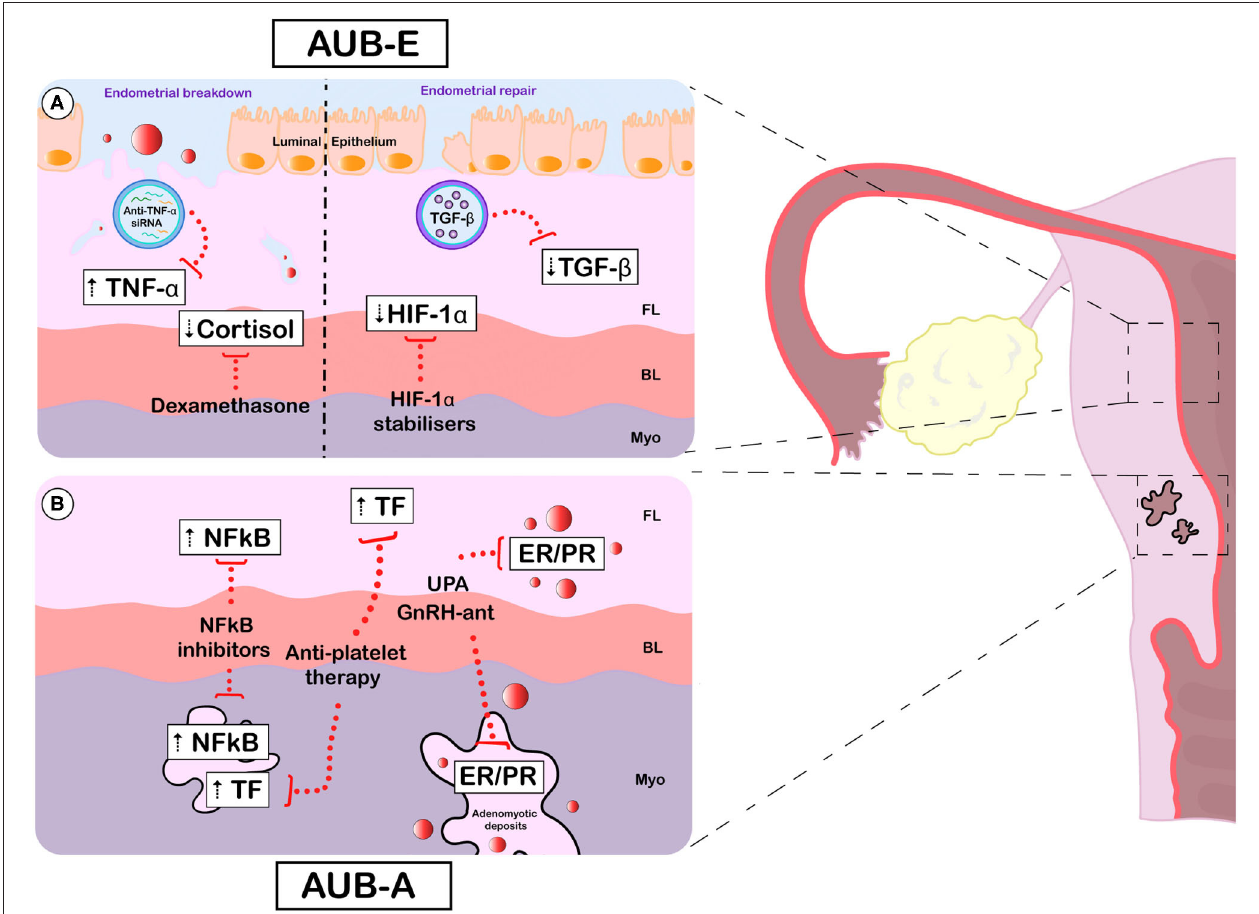
FIGURE 1 | Emerging and potential future treatments for AUB-E and AUB-A. Specific aberrations (white boxes) and emerging therapeutic targets (red dotted lines) for AUB-E (A) and AUB-A (B) . [ (A) , left] During active endometrial breakdown, the TNF upregulation observed in AUB-E could be targeted using nanoparticles loaded with small interfering RNA against TNF. Cortisol deficiency at menses may be restored by administration of the glucocorticoid dexamethasone, which effectively reduces HMB. [ (A) , right] During endometrial repair, pharmacological stabilisation of HIF1A may prevent the delayed repair thought to occur in those with AUB-E. Correcting TGFB deficiency with nanoparticles carrying soluble TGFB may be another strategy to improve the symptom of AUB-E. (B) In adenomyosis, AUB-A may be improved via endocrine manipulation. The selective progesterone modulator UPA and GnRH antagonists have shown promising results in clinical trials by targeting PR and/or ER in adenomyotic deposits and the eutopic endometrium. Therapeutic strategies focused on compensating the overactivation of NF κ B (using NF κ B inhibitors) and TF (using anti-platelet therapy) observed both in the eutopic endometrium and adenomyotic lesions may also be beneficial in AUB-A. AUB, abnormal uterine bleeding; AUB-E, AUB of endometrial origin; AUB-A, AUB due to adenomyosis; FL, functional layer; BL, basal layer; Myo, myometrium; TNF- α , tumour necrosis factor; siRNA, small interfering RNA; TGF- β , transforming growth factor beta; HIF-1 α , hypoxia inducible factor 1 alpha; NF κ B, nuclear factor kappa B; TF, Tissue factor; UPA, ulipristal acetate; GnRH-ant, gonadotropin releasing hormone antagonists; ER, oestrogen receptor; PR, progesterone